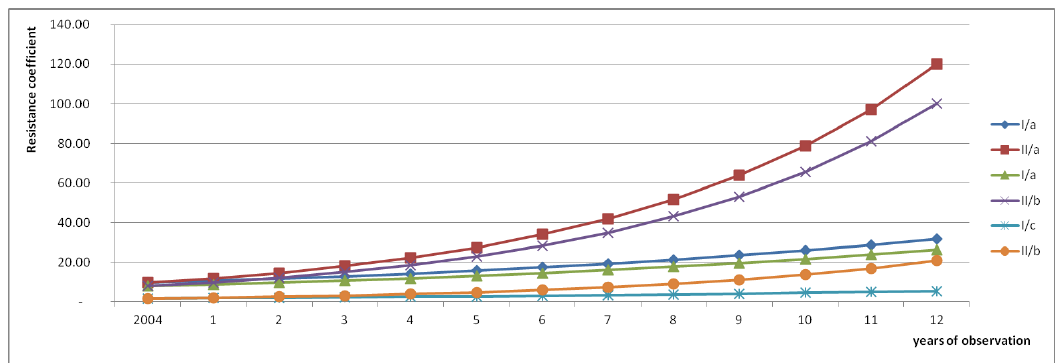
Figure 8. Variability in the resistance coefficient during 2004–2016.